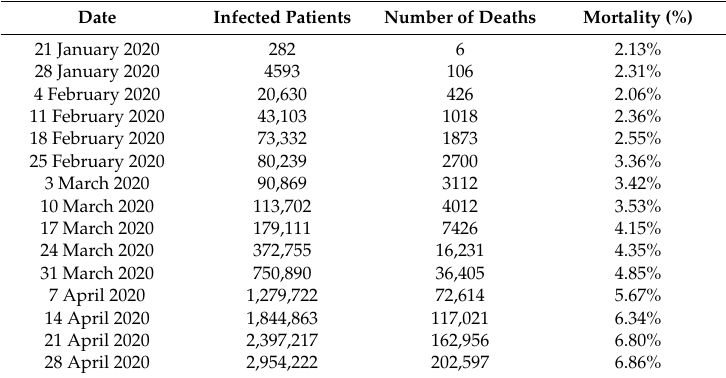
Table 1. Weekly WHO reports regarding an increase in the number of patients suffering from Coronavirus Disease 2019 (COVID-19). Infected Patients Number of